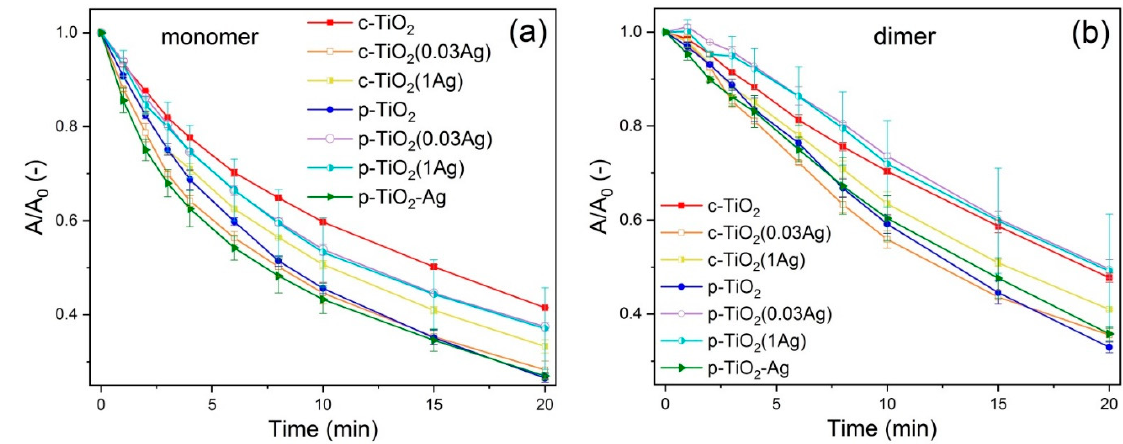
Figure 5. Rhodamine 6G dye degradation with UV illumination shown by A/A 0 − t curves of ( a ) monomer and ( b ) dimer degradation. The monomer degradation is significantly faster than the dimer degradation.